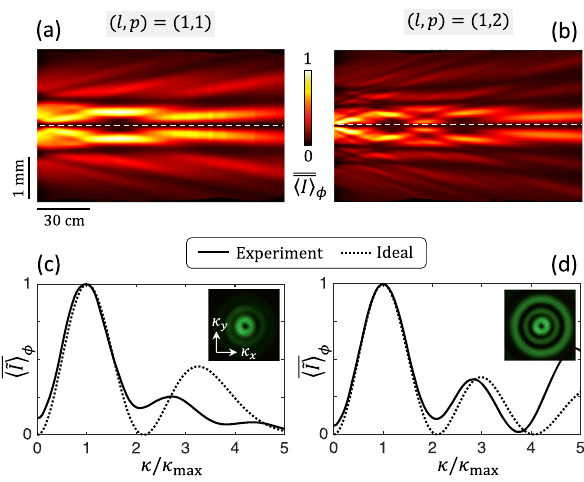
Figure 7: Experimental characterization of the propagation characteristics of modal vortex shapers with ( l , p ) = (1 , 1) and ( l , p ) = (1 , 2). (a) and (b) Reduced azimuth-average intensity distribution in the ( z , r ) plane. (c) and (d) Reduced azimuth-average far field intensity distribution and transverse intensity distributions (insets). The notations and the data recording protocols are identical to that of Figures 3 and